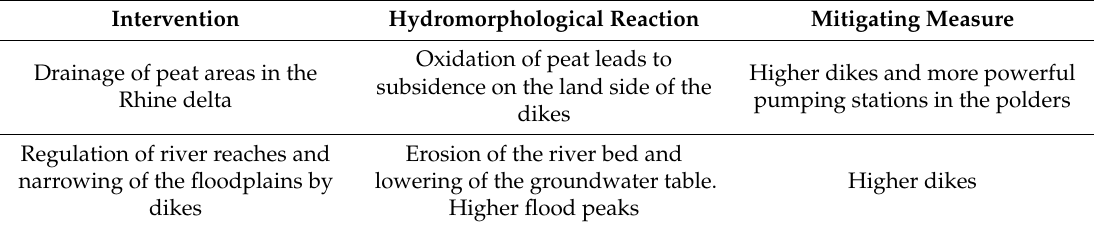
Table 1. Important intervention–response relationships caused by river training interventions.